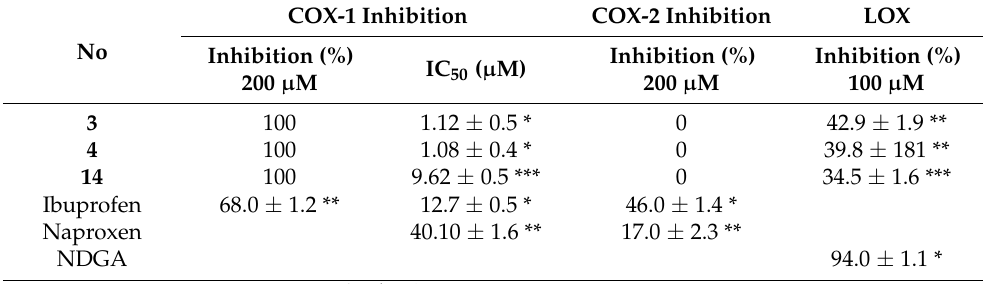
Table 3. Activity effect of selected compounds on cyclooxygenase (COX) -1 and -2, and LOX. COX-1 Inhibition COX-2 No